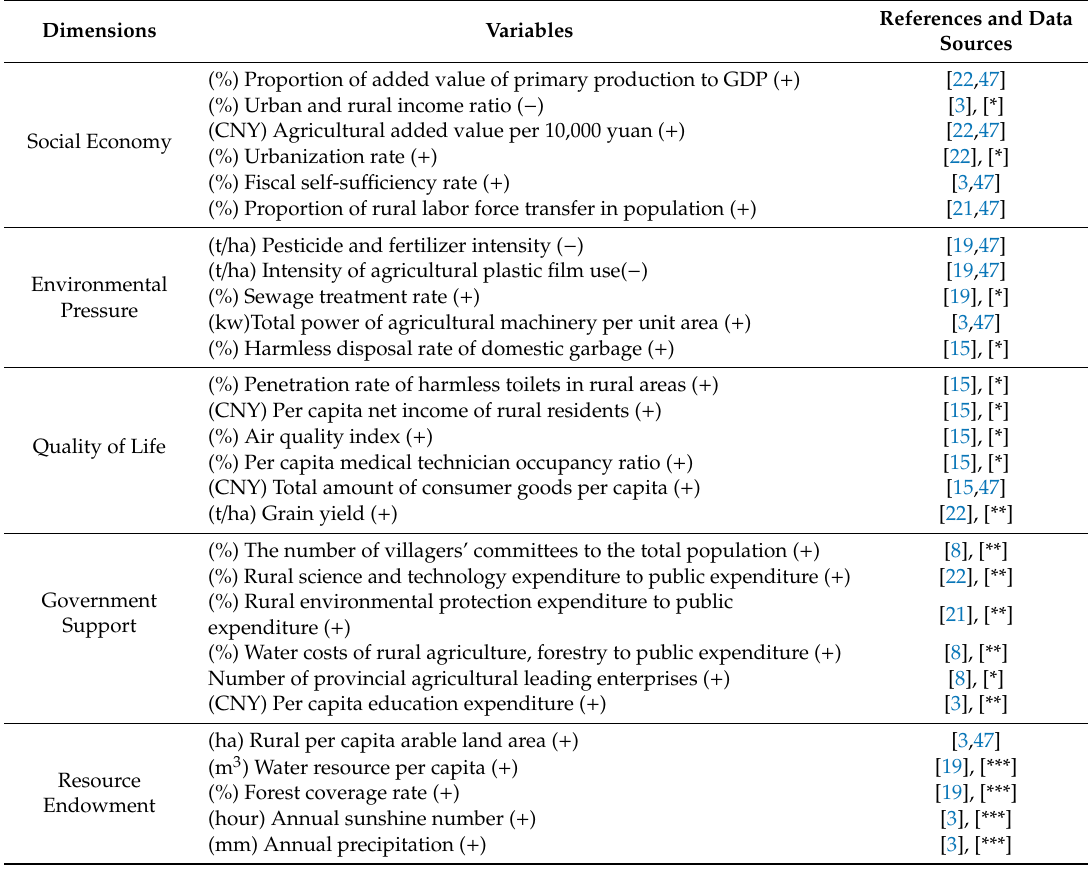
Table 1. Details of the indicators of rural green development in